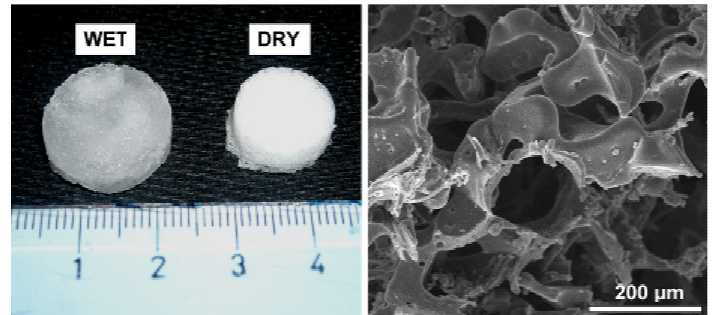
Figure 1. Macroporous scaffolds of poly(ethylene glycol) diacrylate (PEGDA) with high swelling properties for osteochondral